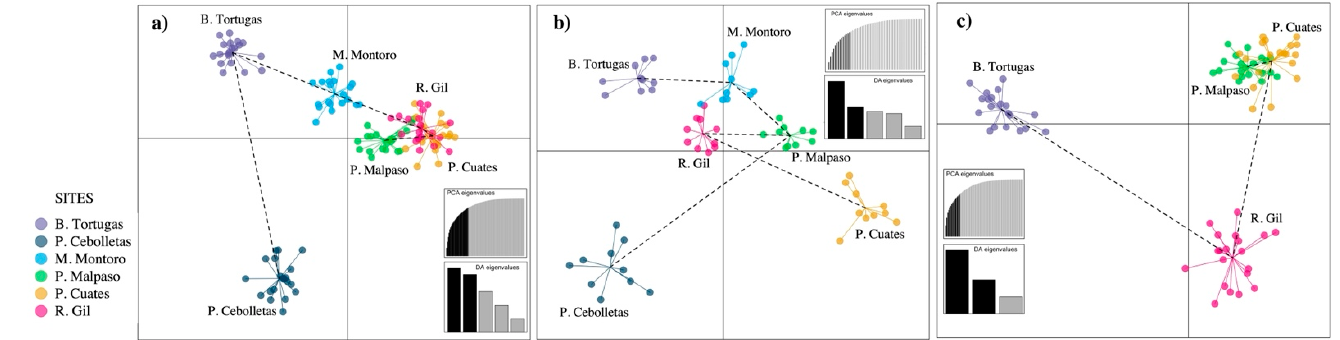
Figure 5. Discriminant analysis of principal components (DAPC) of Pachyphytum caesium without simulation ( a ); with simulation of the extraction of individuals ( b ); and the local extinction of two populations ( c ).